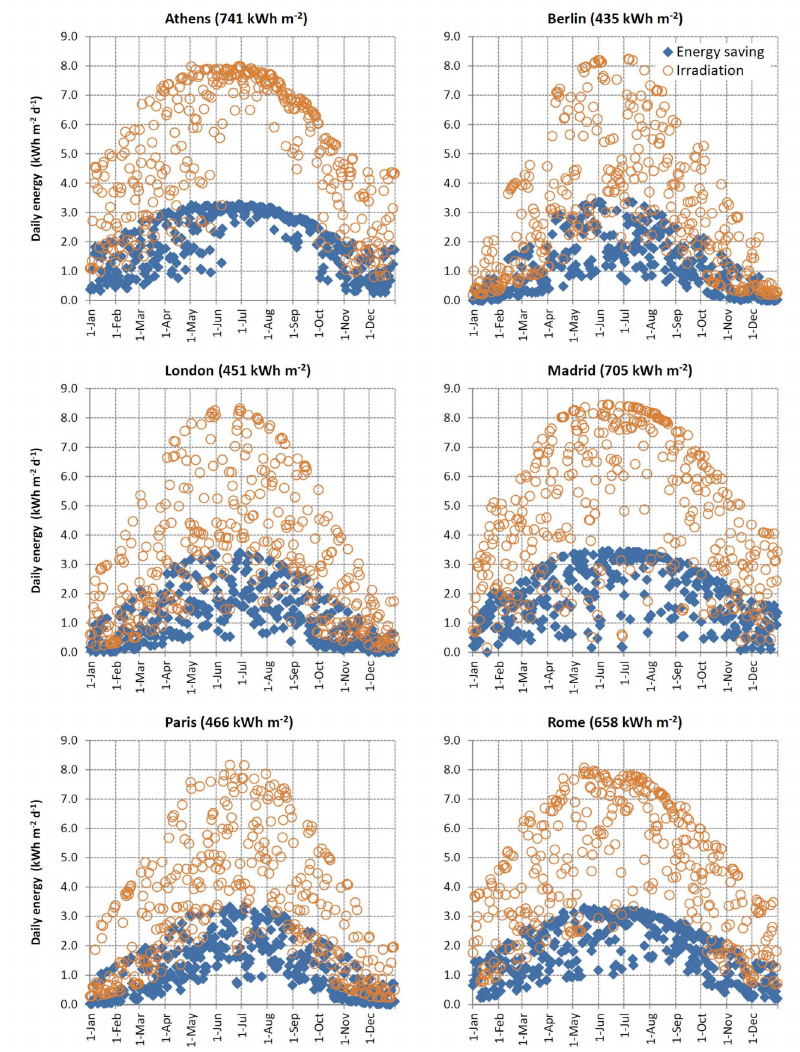
Figure 6. Energy saving of SWHS against